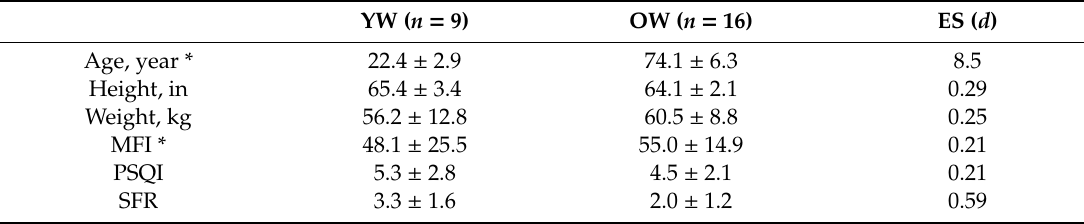
Table 1. Participant